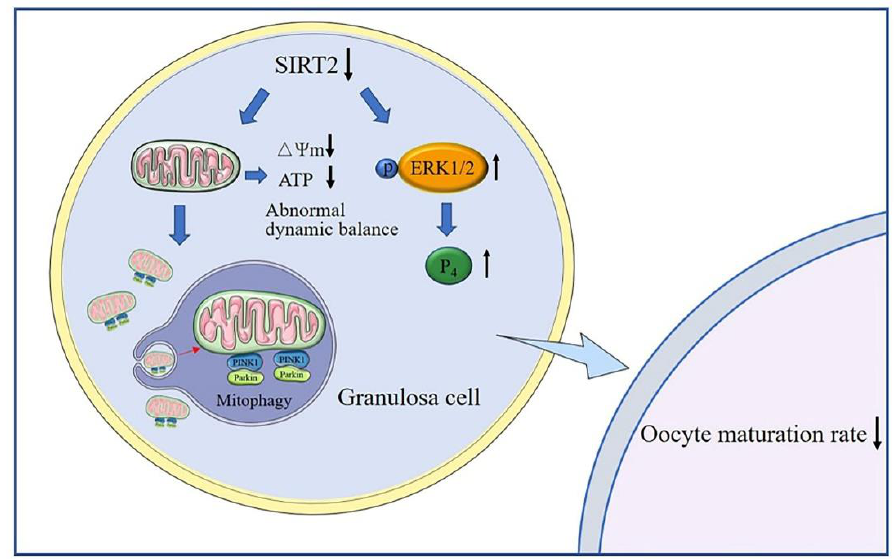
Figure 10. Mechanism of SIRT2 influencing sheep oocyte maturation through regulating surrounding granulosa cells. SIRT2 in granulosa cells is required for sheep oocyte maturation by affecting mitochondrial membrane potential and ATP level, mitophagy, and increasing the P 4 secretion through regulating p-ERK1/2.